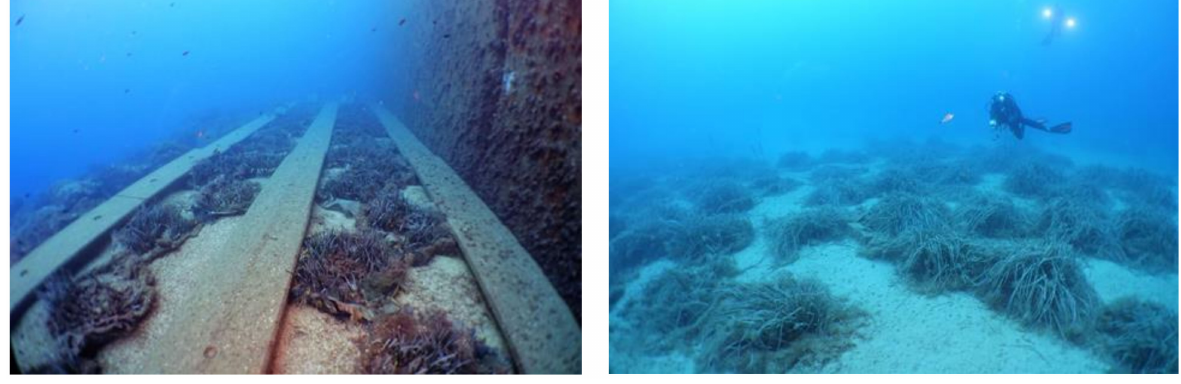
Figure 11. ( Left ) Cement planters with transplanted clods of matte ( Posidonia oceanica ), on a hard bottom at Fonvieille (Monaco), 14 m depth. ( Right ) The transplant site of Larvotto (Monaco), on a sandy bottom, 17–20 m depth. Photos © J é r é mie Godefroy, Sectec, courtesy of the